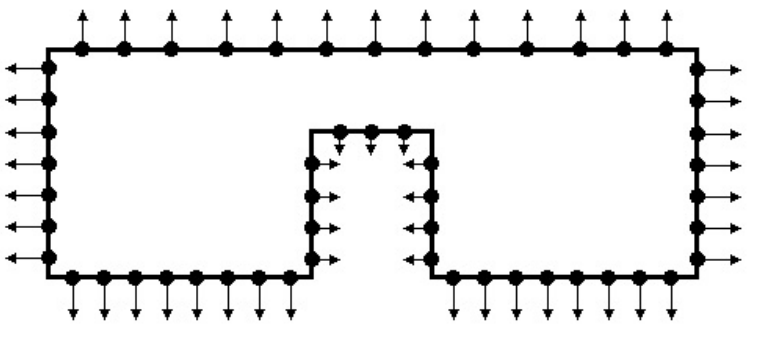
Figure 3. Domain discretization.